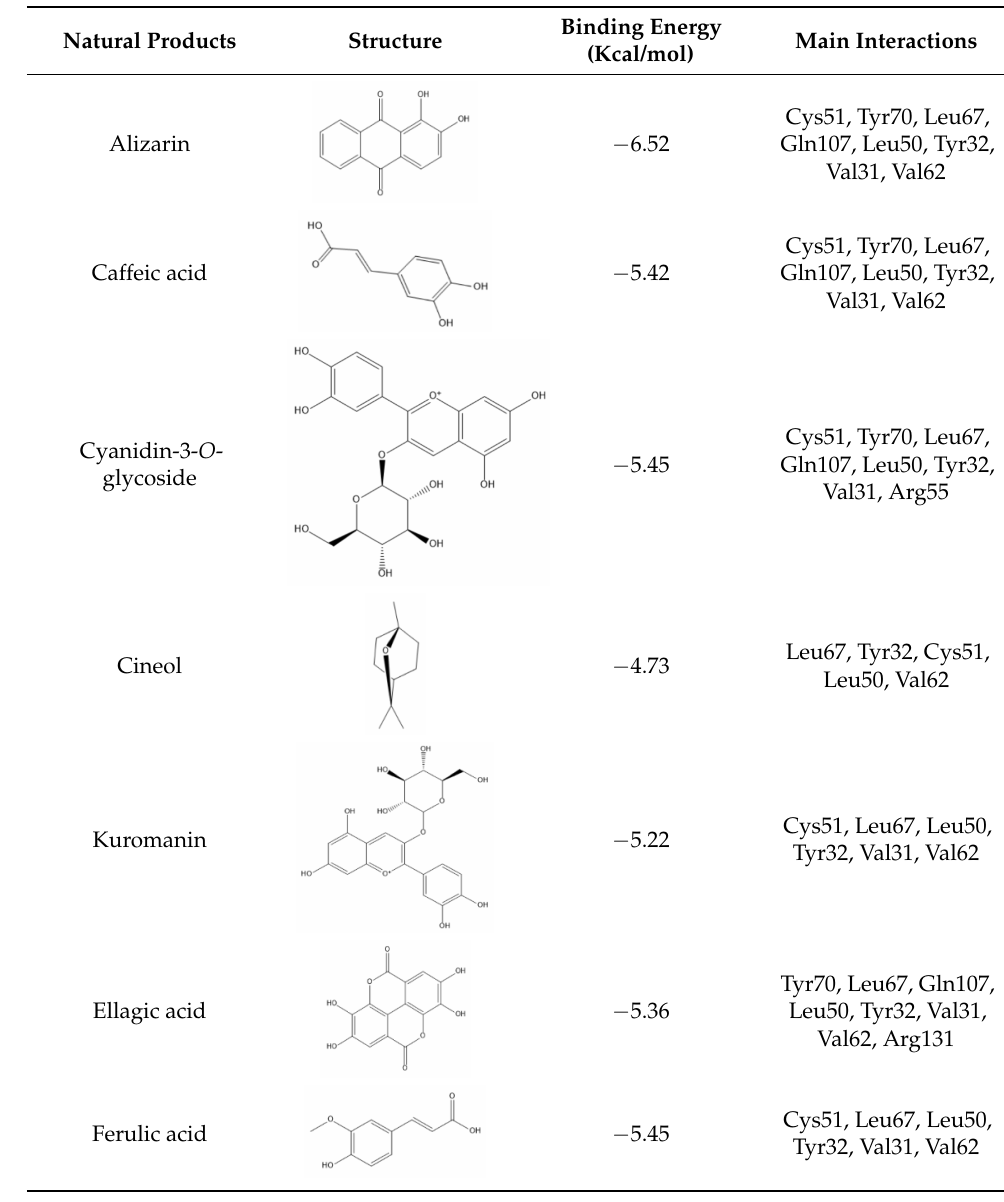
Table 1. List of natural products, including flavonoids, binding energies, and main interactions with the HPV16 E6 protein on the E6AP binding